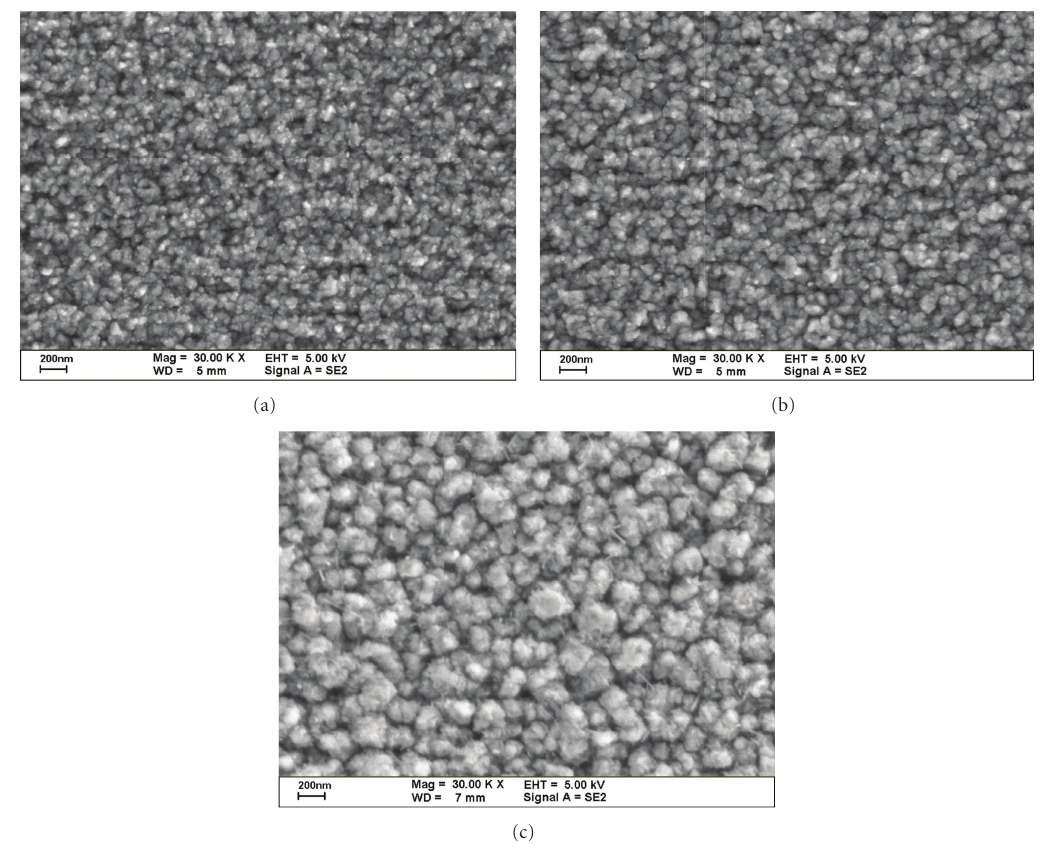
Figure 3: SEM images of the samples with thermal oxidation at various temperatures.